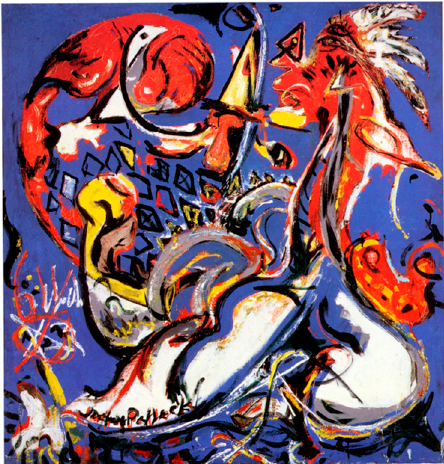
Figure 13. Jackson Pollock, Moon Woman Cuts the Circle , 1943, oil on canvas, 42 × 40 in. (109.5 × 104.0 cm). Musee National d’Art Moderne, Centre Georges Pompidou, Paris. © 2022 The Pollock-Krasner Foundation/Artists Rights Society (ARS), New York.